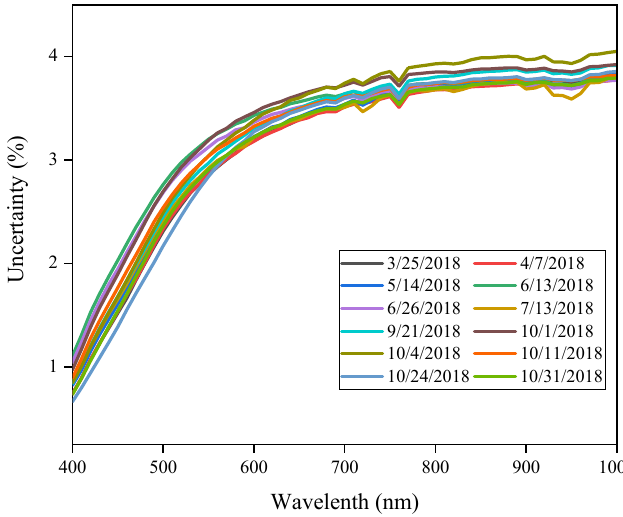
Figure 13. The uncertainty results of the predicted top-of-atmosphere (TOA) reflectance associated with the combined uncertainty of the desert target surface reflectance covering 400 nm to 1000 nm on the study dates. Table 4. The uncertainty results of the predicted TOA reflectance caused by surface characteristics in bands 2, 3, 4, and 8 of Sentinel-2B/MSI.